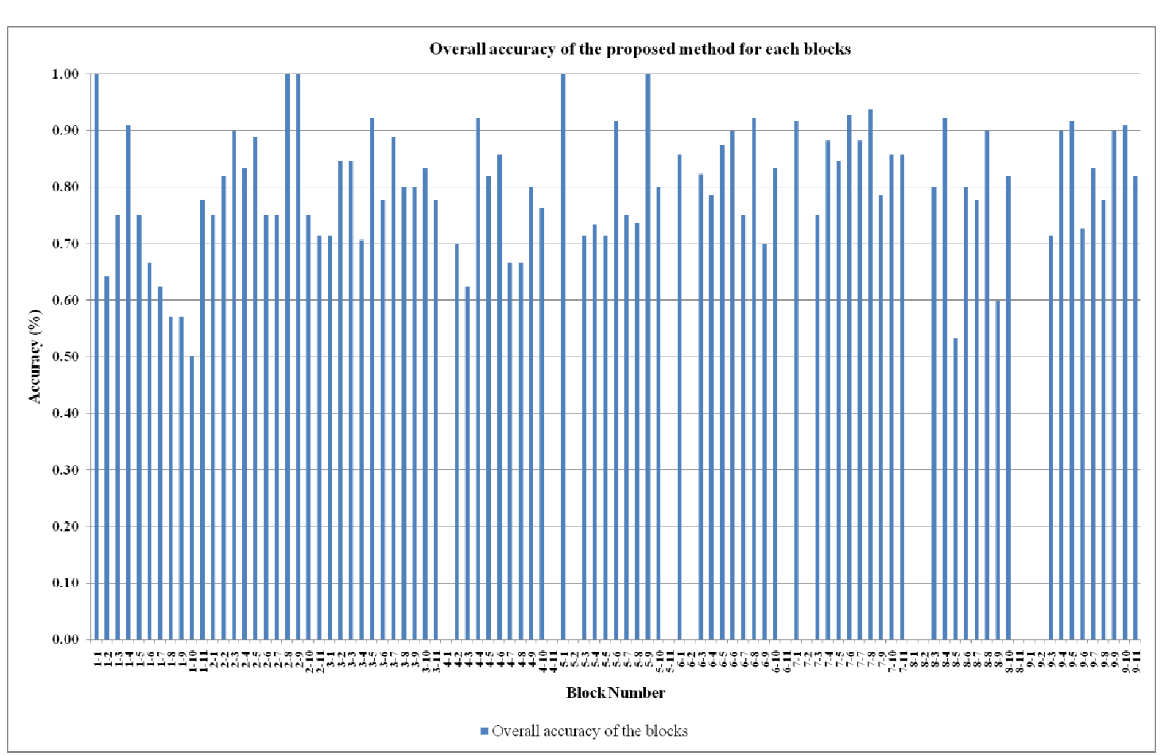
Figure 7 . Overall accuracy the proposed method for each